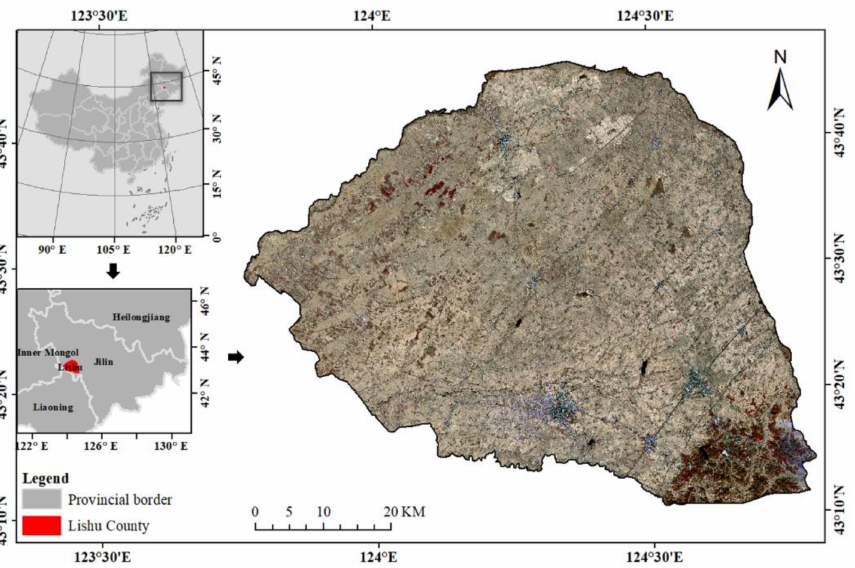
Figure 1. The location of the study area (Lishu County) and covered GF-1 B/D image (Near-infrared: Band 4, Red: Band 3, Green: Band